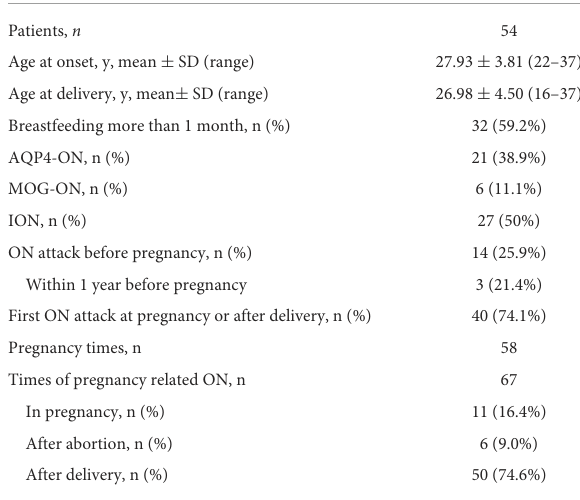
TABLE 1 Clinical spectra and time distribution in patients with pregnancy-related